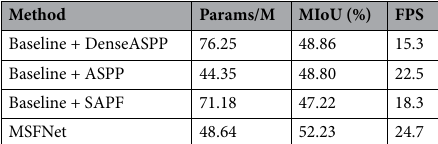
Table 3. Ablation experiment of context module.